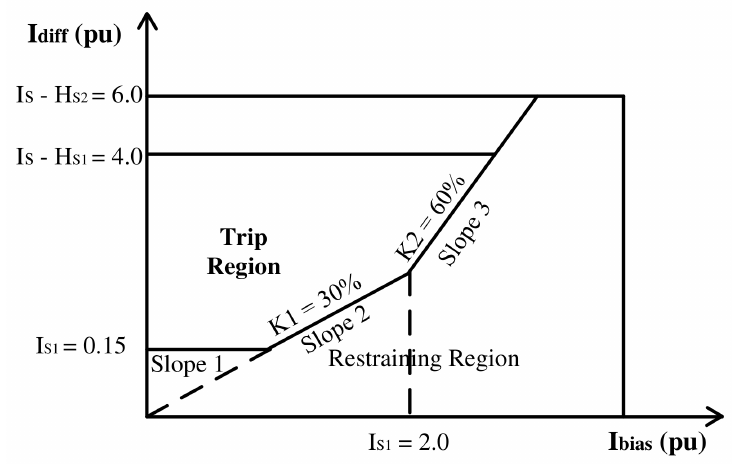
Figure 4. Differential characteristics or bias characteristics implemented in